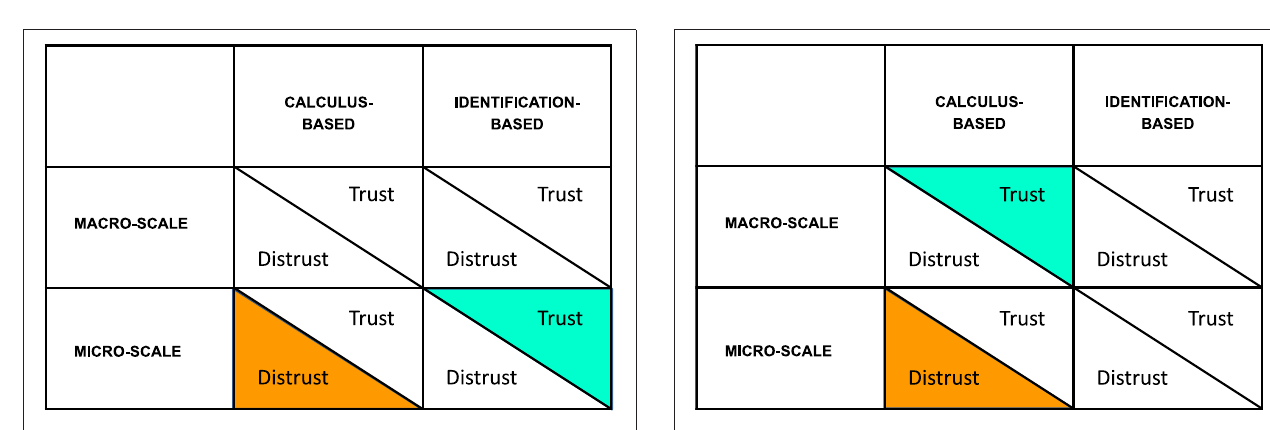
FIGURE 3 | “He’s my brother, but he let me down the last three times I needed him.”